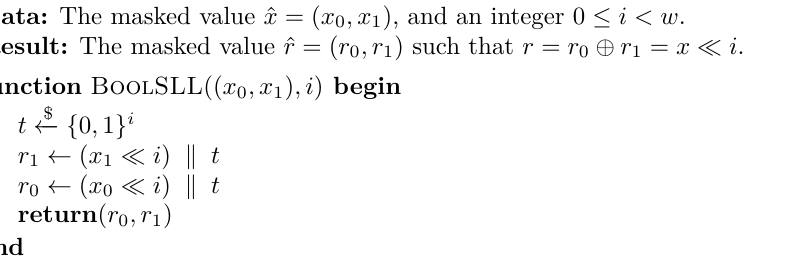
Algorithm 12: BoolSLL : apply left-shift operation (under Boolean masking).